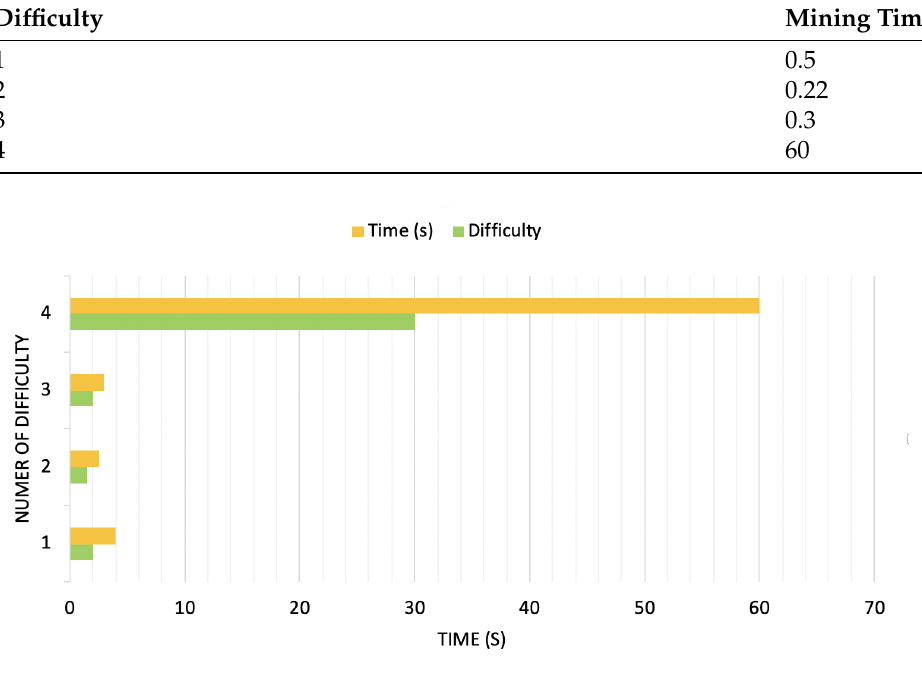
Figure 14. Difficulty level of time taken for